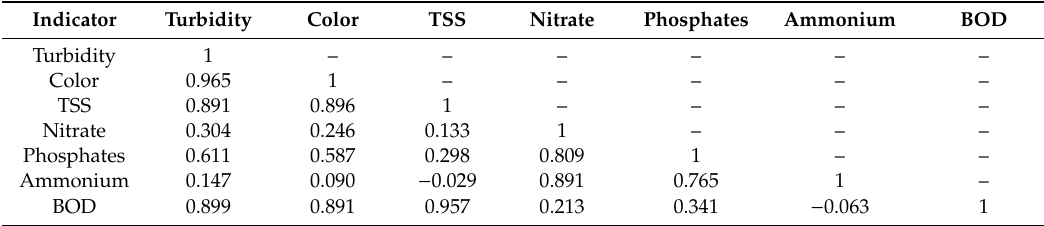
Table 7. Correlation of some physicochemical parameters from the Al–Ti combination.